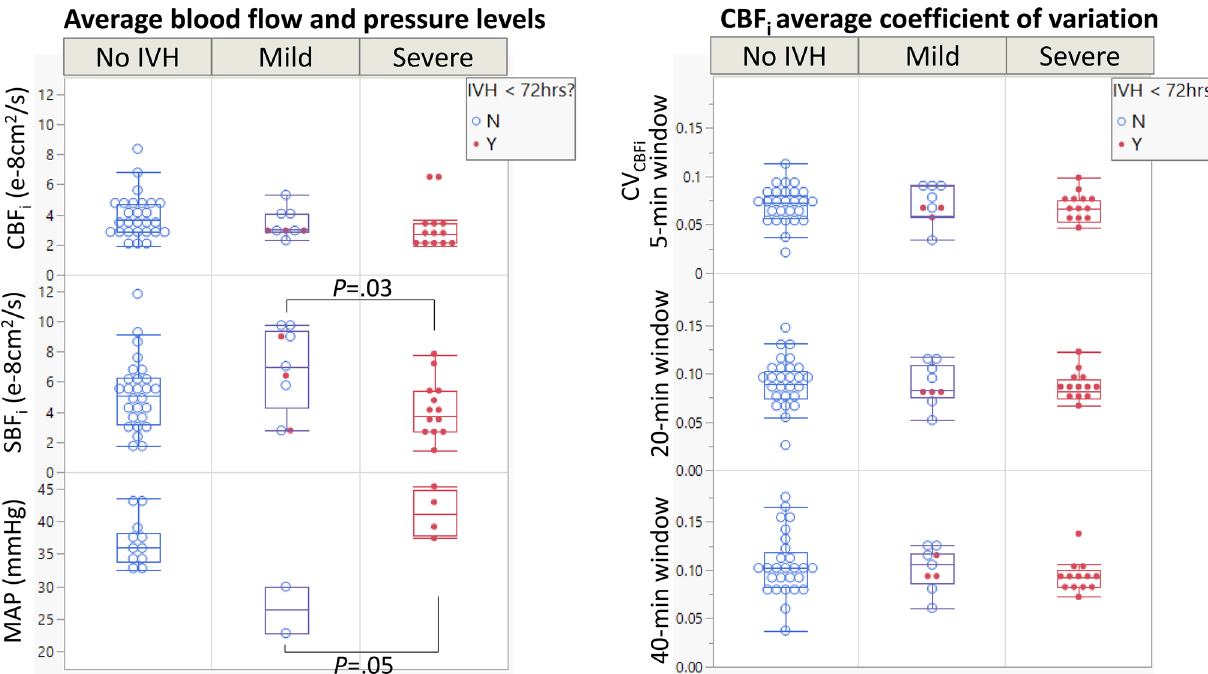
Figure 4. CBF i fluctuation was not different between IVH groups, based on the coefficient of variation method (CV CBFi ). Each point was based on one day of measurement. Notable differences include a significantly lower scalp blood flow, while showing a higher mean arterial pressure, in the severe-IVH group ( P values shown are based on Tukey post-hoc test. A linear mixed model was used to account for multiple measurements in each subject).